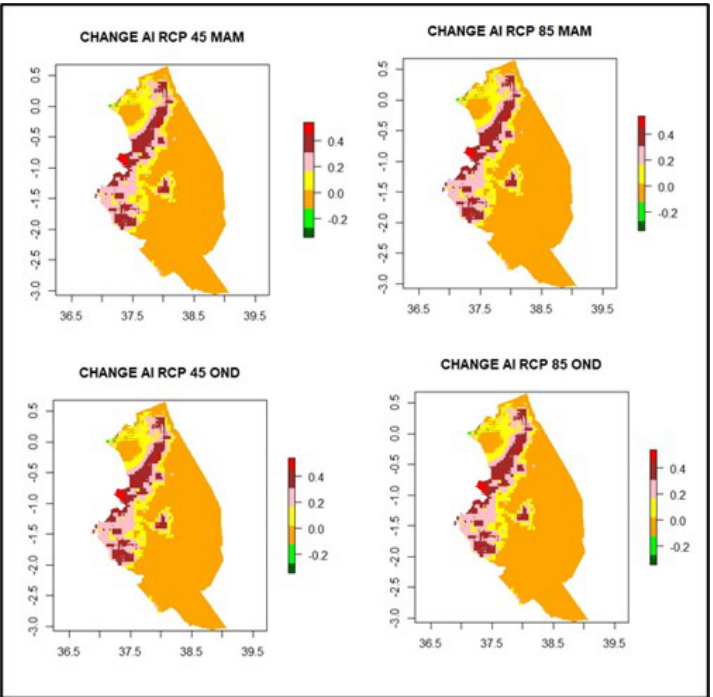
Figure 7. Changesin aridity index during MAM, OND in 2040 for RCPs 4.5 and